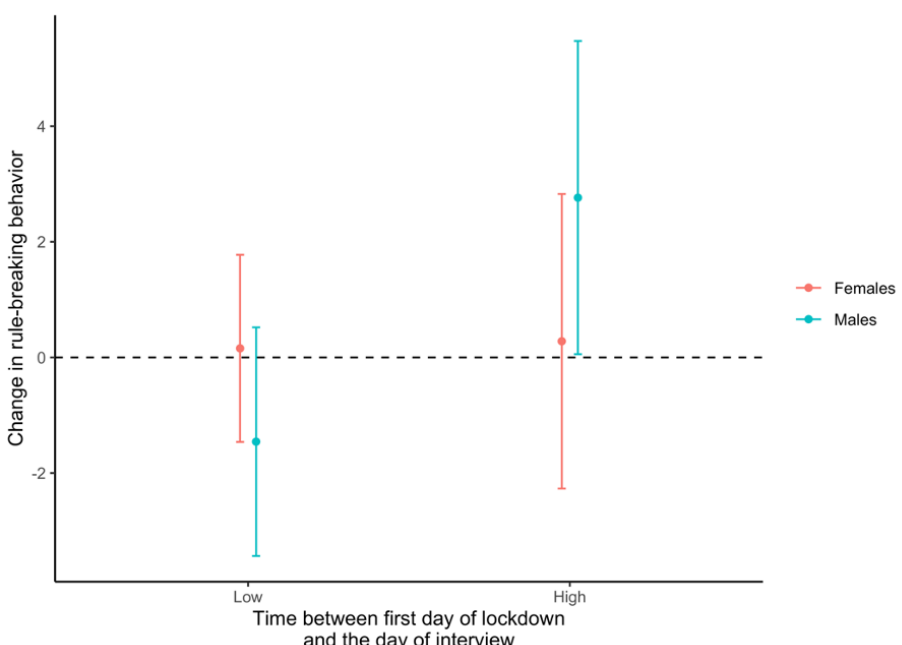
Figure 3. Sex-specific effects of social isolation and Rule-Breaking Behavior. Results from the linear regression model including an interaction term between time in social isolation and sex. Here are displayed the marginal effects of the time spent in social isolation (<14 weeks vs. ≥ 14 weeks vs. low) on the difference in the ASR Rule-Breaking Behavior score by sex. The model was adjusted by age (years), SES and IQ. The statistical significance for males with a longer time spent in social isolation is p = 0.046.